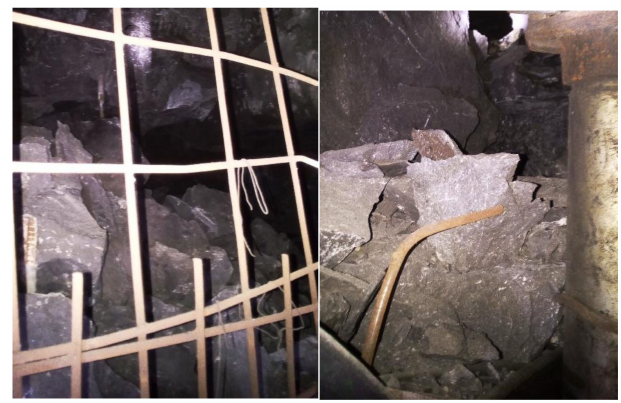
Figure 1. Fractured porous rock mass.